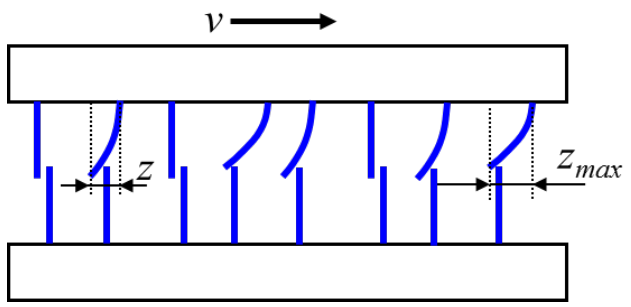
Figure 5. Contact based on bristle model.